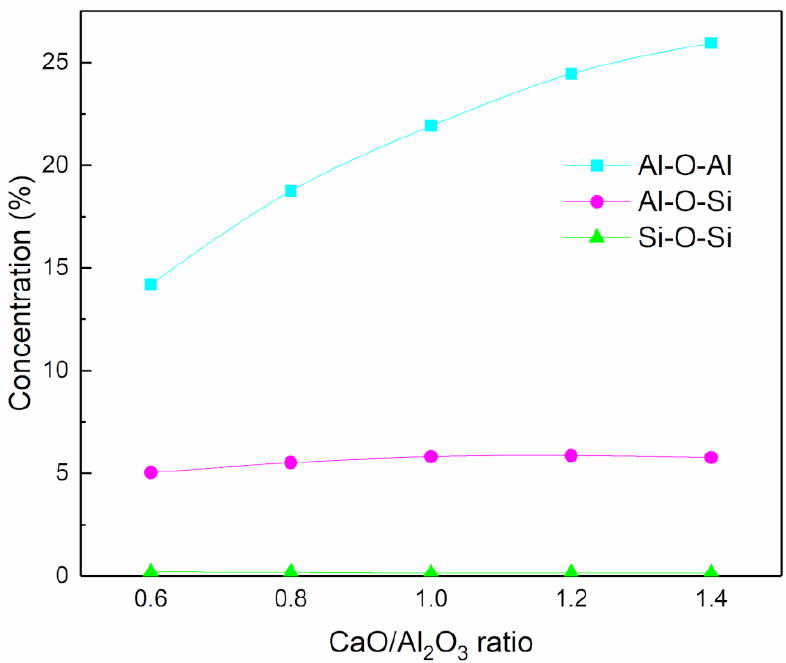
Figure 5. Evolution of different bridging oxygens with various CaO/Al 2 O 3